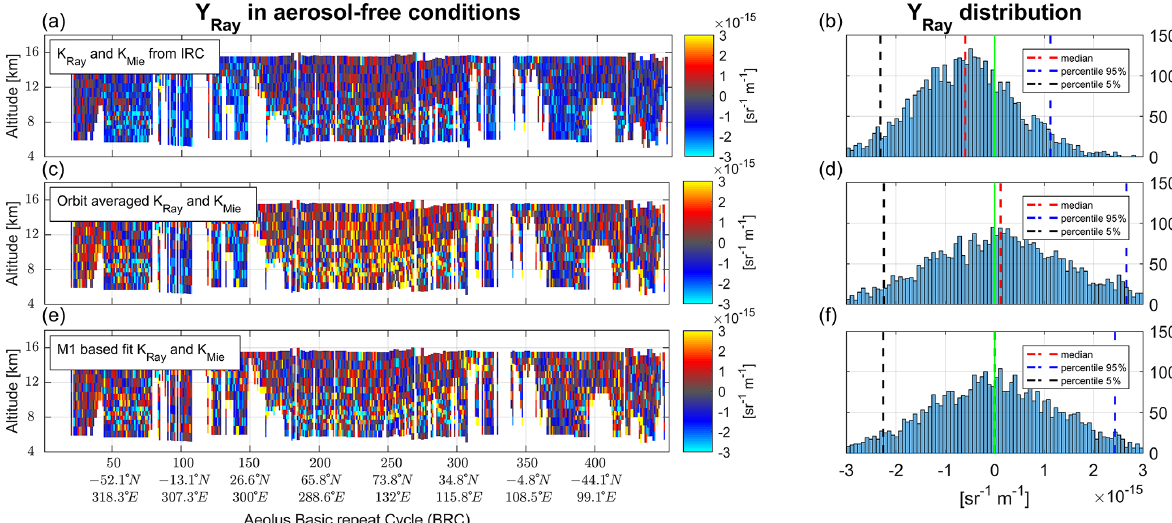
Figure 8. The evolution of calibration schemes and the resulting improvement of error in signal prediction on orbit no. 14213 (acquired on 4 February 2021). The left panels show the cross-talk-corrected “pure particulate signals” in “particle-free” bins; the histograms on the right show the distributions of these